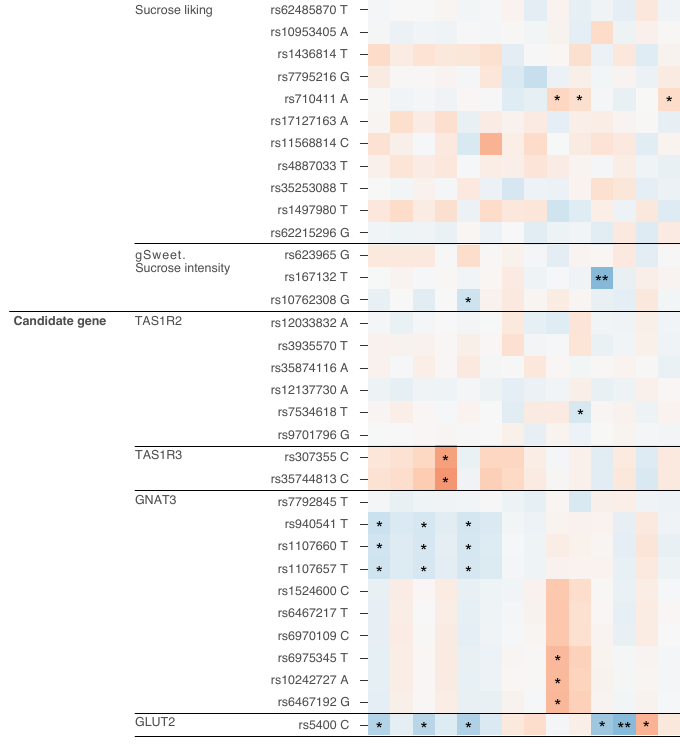
Figure 2. Associations between all primary and secondary SNPs and dietary variables in the MDCS cohort. The effect sizes are presented as β /SEE. TAS1R2: Taste receptor type 1 member 2 gene. TAS1R3: Taste receptor type 1 member 3 gene. GNAT3: G protein subunit alpha transducin 3. GLUT2: Glucose transporter 2 gene. SEE: Standard error of the estimate. MDCS: Malmö Diet and Cancer Study. 1 Sucrose and all monosaccharides. 2 Rs2192762 was associated with both NHDC and gSweet intensity in Hwang et al. [16]. * p < 0.05, ** p <